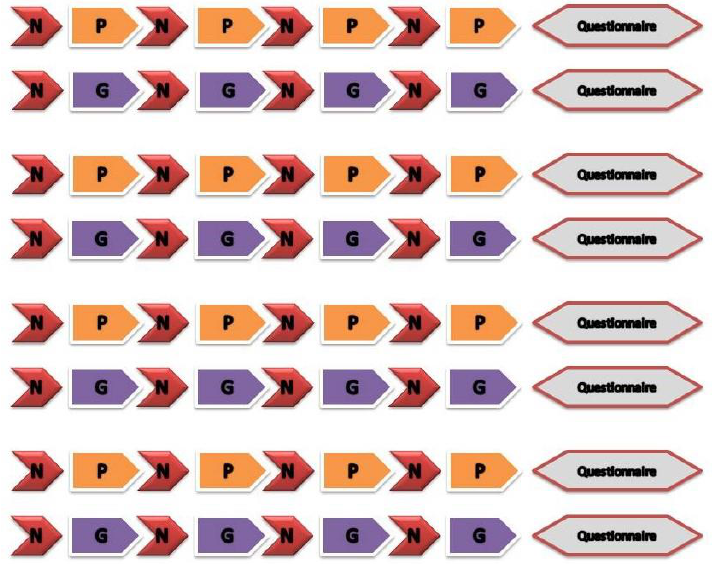
Figure 3. Eight emotional blocks (4 for pleasure emotion and 4 for grief emotion) with questionnaire.